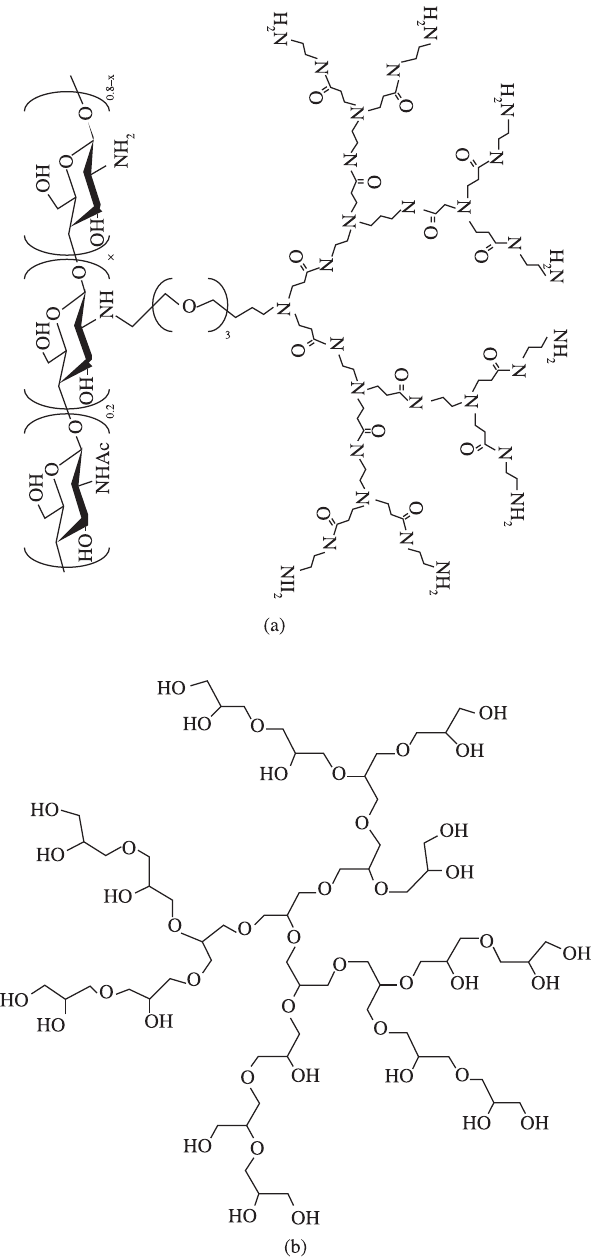
Figure 1. Schematic architectures of the CHD (a) and PGLD (b) dendrimers synthesized in this work for GOx immobilization. moment were not well characterized electrochemically in